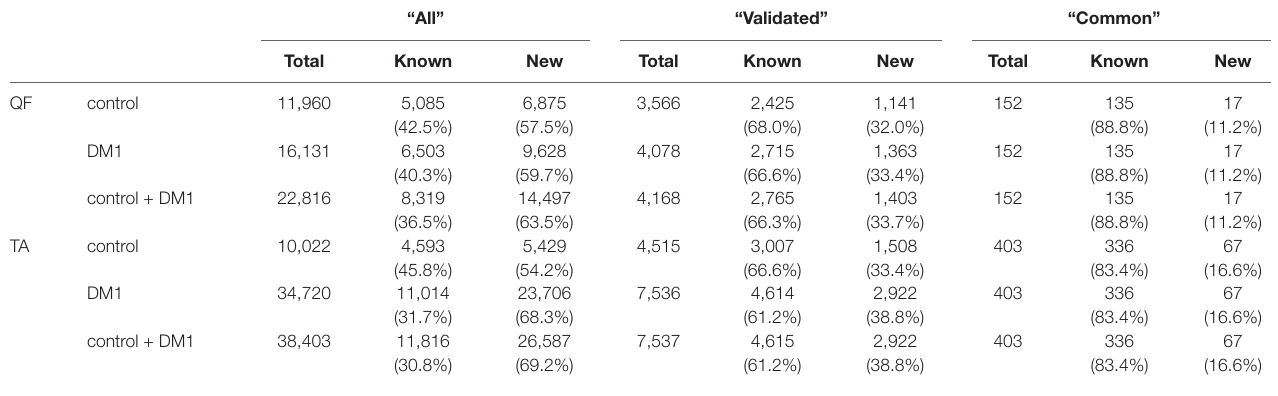
TABLE 4 | Number of circRNAs in quadriceps femoris (QF) and tibialis anterior (TA) tissues in different validation groups. “All”